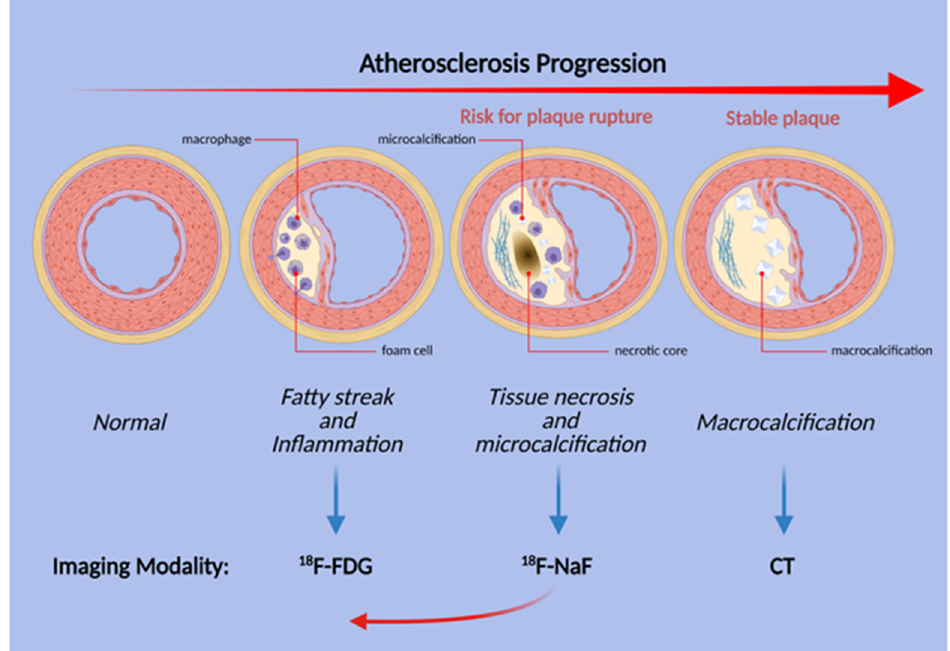
Figure 3. Schematic illustration of the stages of atherosclerosis in the coronary arteries. Uptake of both FDG and NaF is evident before the structural changes are visible, but inflammation and FDG uptake does not necessarily precede microcalcification. Thus, NaF uptake may be present earlier than previously thought (red arrow).